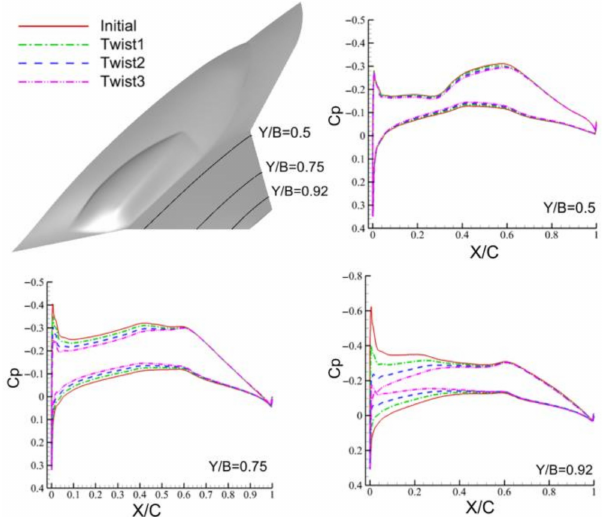
Figure 15. The positions and pressure coefficient distributions at typical sections of the different twisted configurations. Ma = 0.85, α = 2 ◦